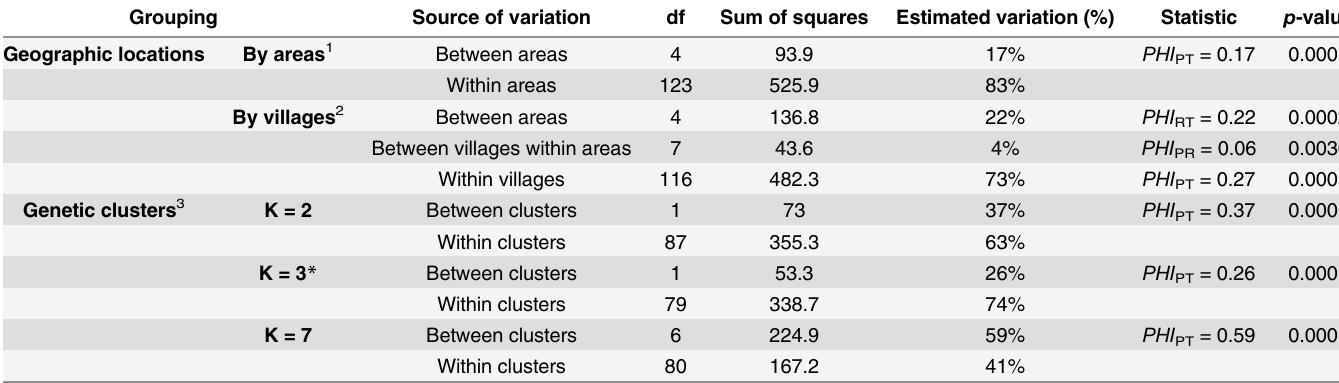
Table 1. Summary of hierarchical AMOVA for different geographical groupings and genetic clustering.